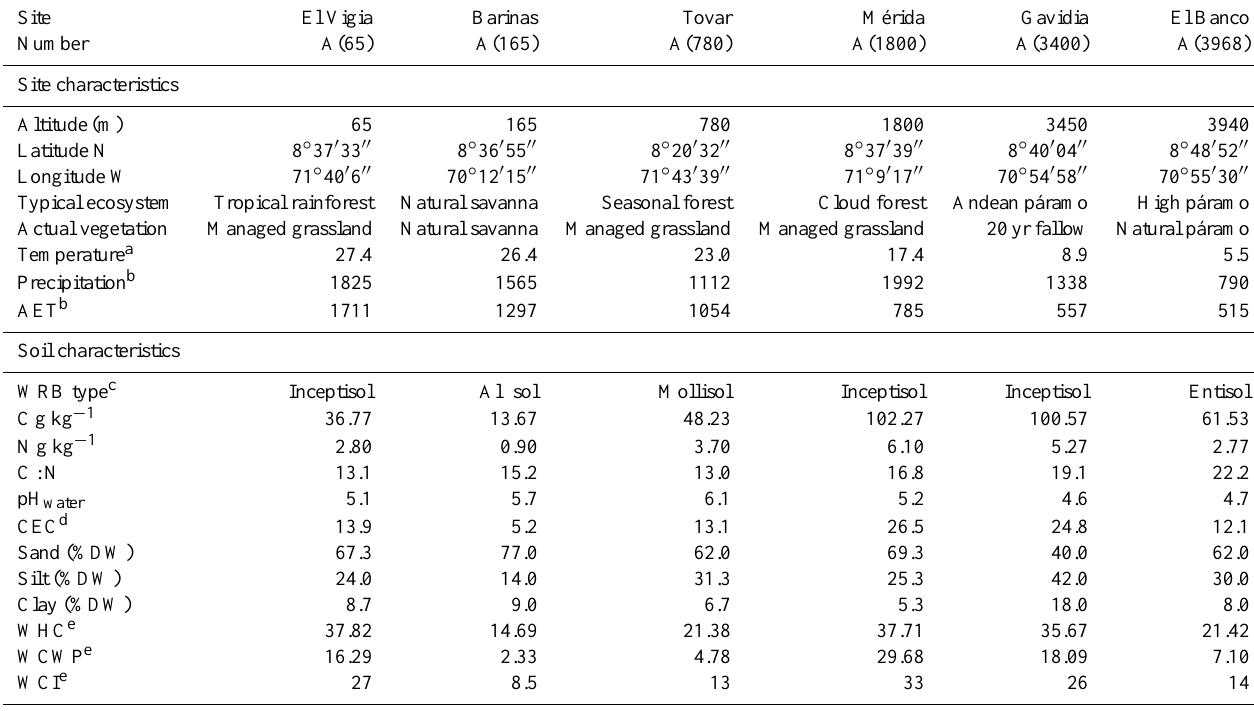
Table 1. Site characteristics.